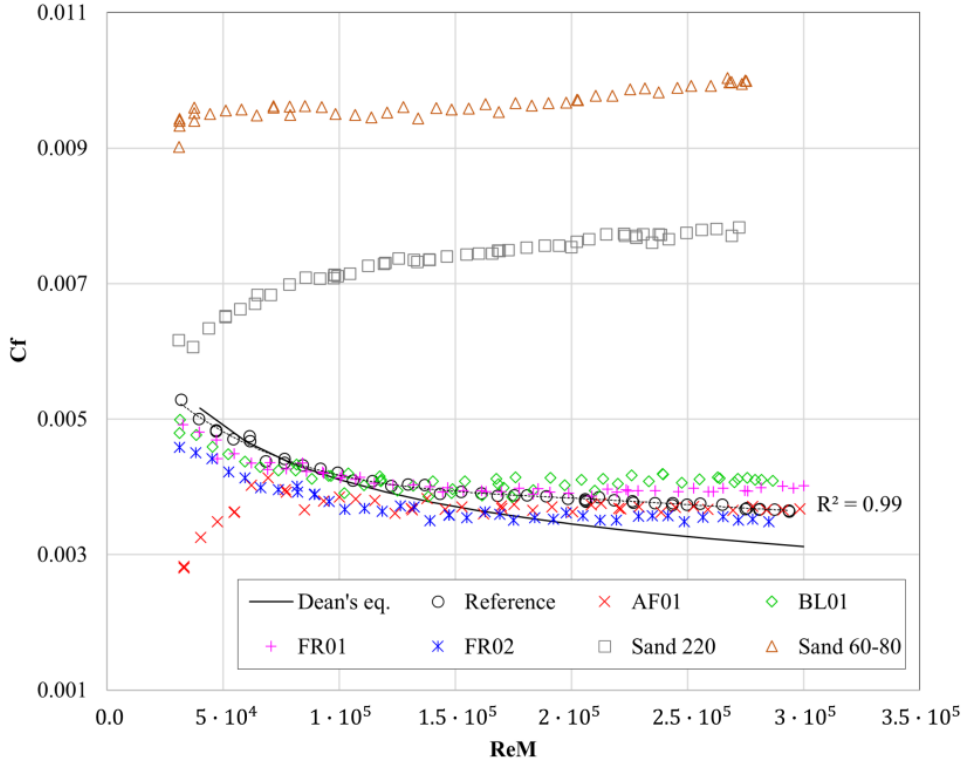
(cid:16) (cid:17) c f vs. Reynolds number ( Re M ) for all marine coating ) vs. Reynolds number ( 𝑅𝑒 𝑓